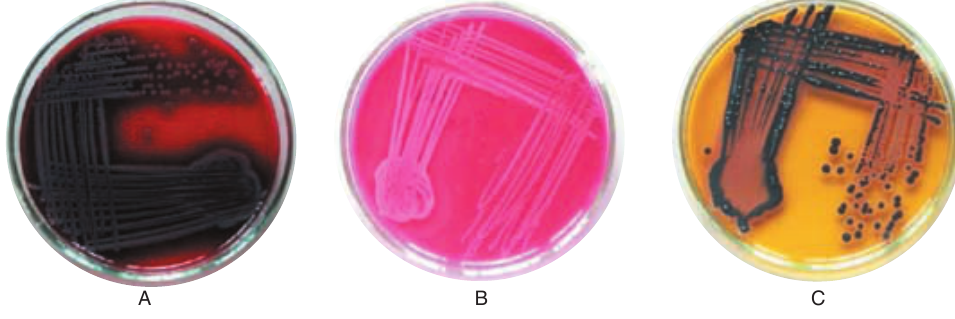
to be due to poor selection pressure induced by the drug. The findings also agree with that of Jahantigh and Nili (2010) who reported high level of resistance towards tetracycline among salmonella in pigeons. The varying resistance to antimicrobials among different populations of fancy pigeons could be because of different preferences of antimicrobials being used in different localities (Kaczorek-Lukowska et al .,